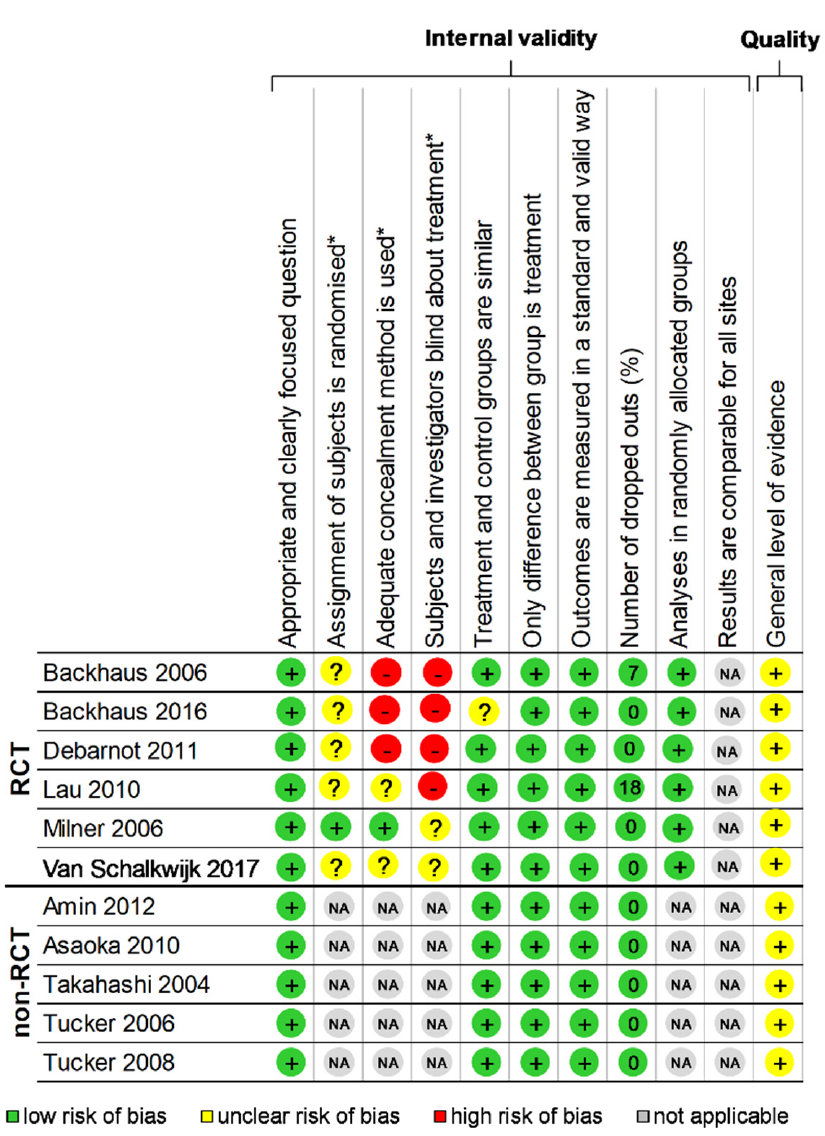
Figure 2. Methodological quality of included articles and summary bias risk. Using the “Scottish Intercollegiate Guidelines Network” (SIGN) Methodology checklist 2 Yes: +; No: -; Can’t say: ?; Not applicable: NA; RCT: Randomized controlled trials; * item only for randomized studies.